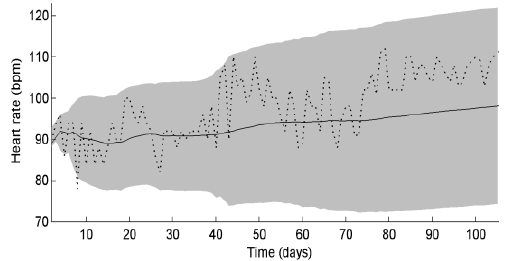
FIGURE 1: Time-series of HR „deterioration‟ (dotted), and estimated marginal mean HR (line), with ± estimated marginal deviation in grey where n = 1,2,…, N is the sample number, and a b are the rate and shape of the Gamma distribution, n respectively, which describes the distribution of the precision λ . β